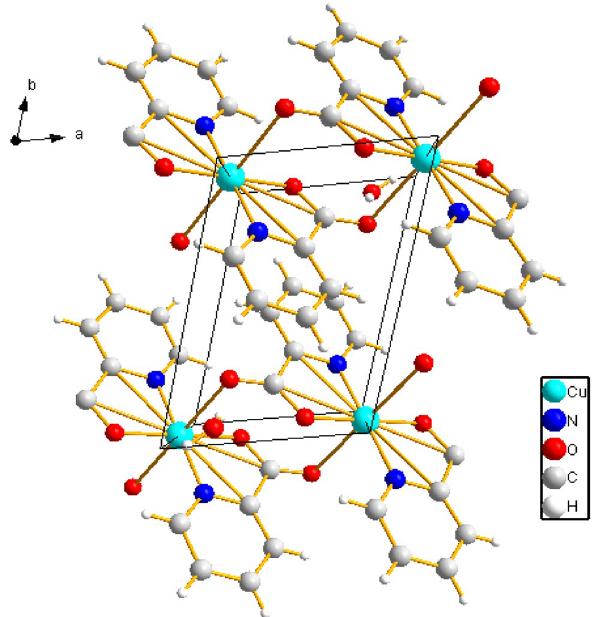
Fig. 2 Crystal packing of CP-1